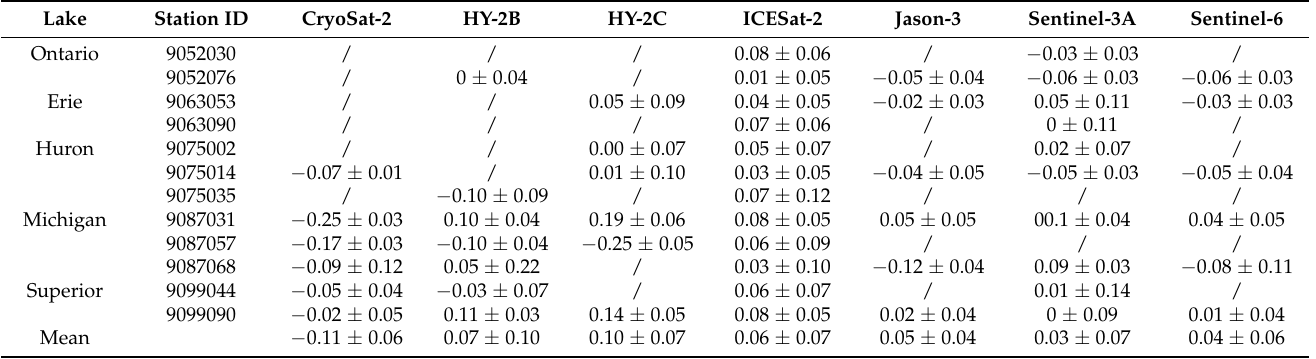
Figure 5. Time series comparison of satellite measured water level and the in-situ data around 12 stations in the Great Lakes from 1 January 2021 to 1 April 2022. Table 7. Bias of seven altimetry satellites at twelve stations in the Great Lakes (unit: m).